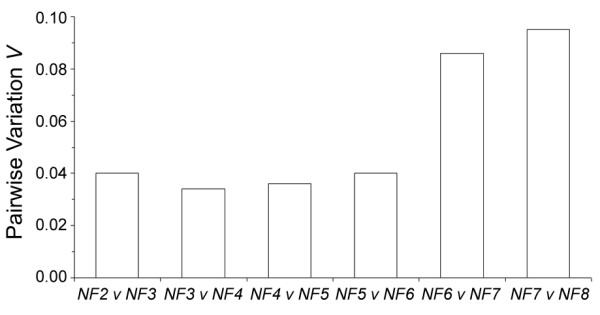
Pairwise variation of sequential normalisation factors (NFn vs. NFn+1) estimated by geNorm. NF2 is based on the geometric mean of GAPDH and UBC; NF3 is NF2 and Act; NF4 is NF3 and WARS; NF5 is NF4 and SDH; NF6 is NF5 and TBP; NF7 is NF6 and 28S; NF8 is NF7 and 18S (gene name abbreviations as Table 1).